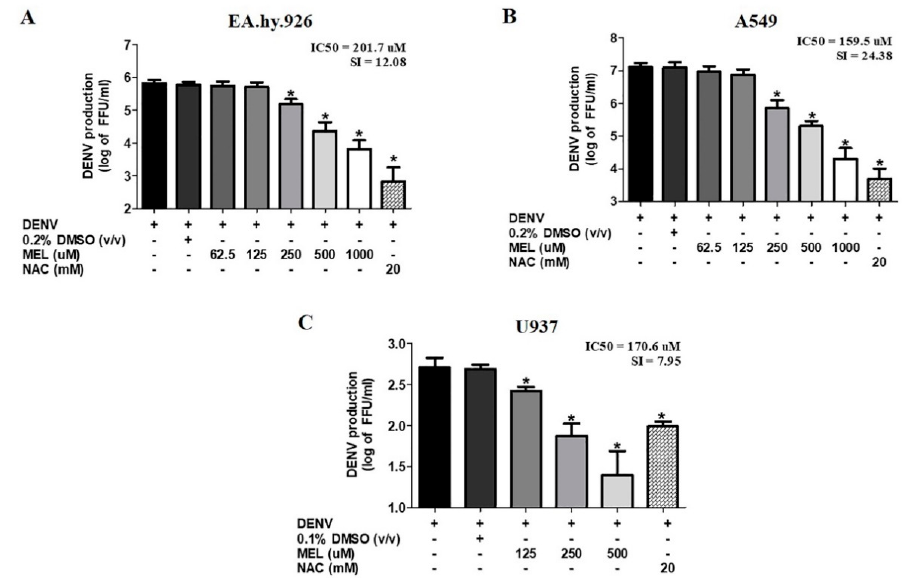
Figure 3. Antiviral effect of MEL in different cell lines. ( A ) EA.hy.926, ( B ) A549, and ( C ) U937 cells were infected with DENV2 at MOI 1 and treated with vehicle control or various concentrations of MEL or 20 mM NAC. Culture supernatant were collected at 24 h pi and FFU assay was done. The asterisk (*) sign denotes p < 0.05 considered to be statistically significant.